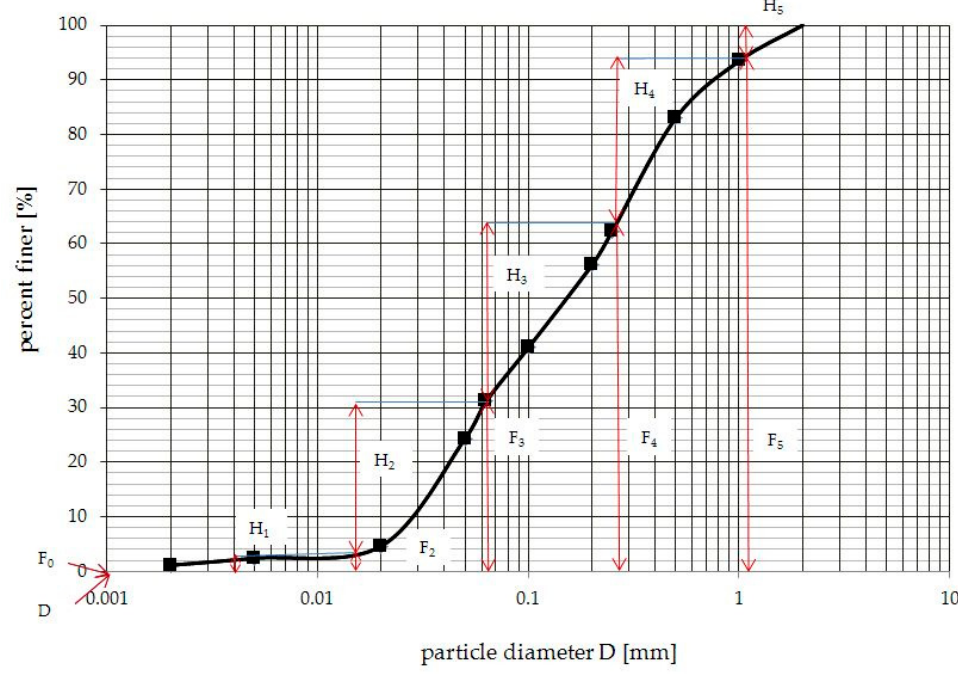
Figure 6. Particle size distribution curve of silty sand and coordinates for the construction of soil internal stability graphs according to Kenney and Lau [45].